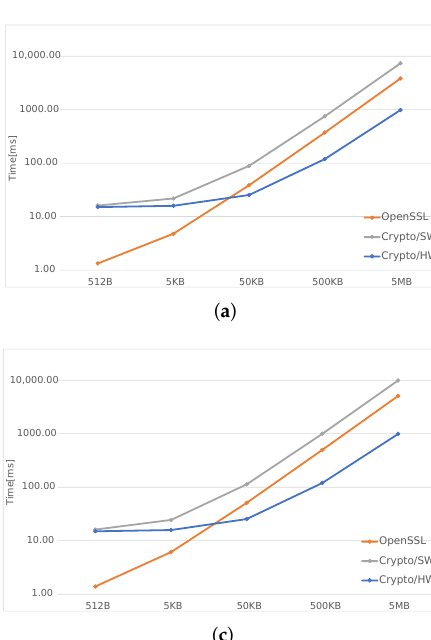
Figure 3. Time required to compute each SHA algorithm on increasing file sizes. ( a ) SHA-224. ( b ) SHA-256. ( c ) SHA-384. ( d ) SHA-512.